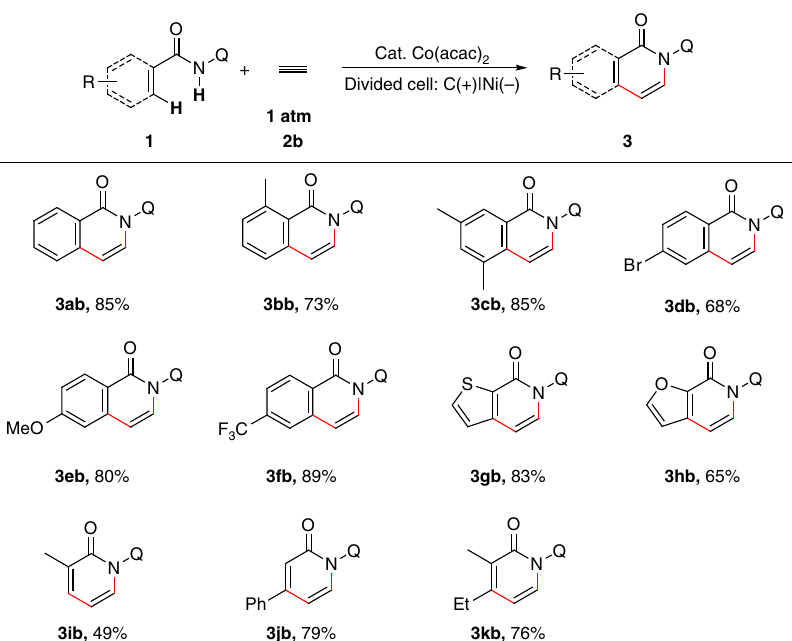
Fig. 3 Electrooxidative C – H/N – H [4 + 2] annulation with ethyne. Reaction conditions: 1 (0.20 mmol), Co(acac) 2 (10 mol%), NaOPiv·H 2 O (2 equiv), n Bu 4 NBF 4 (3.0 equiv), CF 3 CH 2 OH (8.0 mL) [anode], and NaOPiv·H 2 O (2.0 equiv), HOPiv (10 equiv), MeOH (8.0 mL) [cathode] in and H-type divided cell with carbon cloth anode, nickel plate cathode, and an AMI-7001-30 membrane, constant current = 5.0 mA ( J anode = 2.2 mA/cm 2 ), ethyne balloon (1 atm), 70 °C, 3 h (2.8 F/mol). Isolated yields are shown